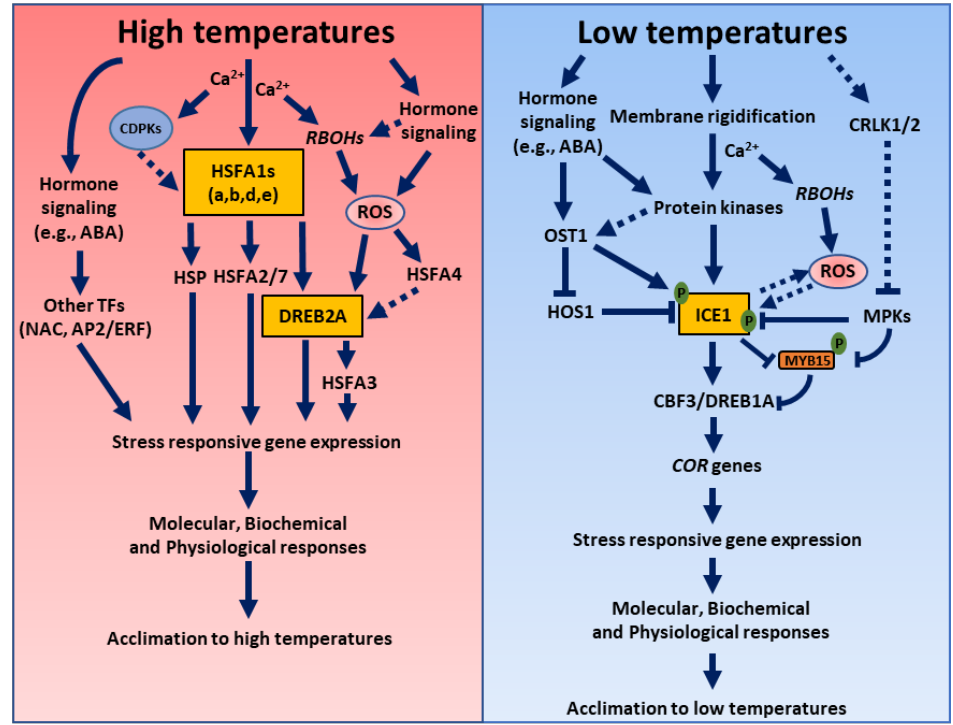
Figure 1. A schematic model showing coordination between various signaling components to induce acclimation responses to temperatures stress. The interplay between the ROS; hormones; and other signaling components such as Ca 2+ , CDPKs, MAPKs, and TFs determines the plant’s molecular, biochemical, metabolic and physiological responses to high or low temperatures. Left panel: Heat stress affects the membrane fluidity and simultaneously triggers hormone signaling pathways, resulting in increased cytosolic calcium, reactive oxygen species, and the activation of other cytoplasmic proteins. The intercellular calcium activates CDPKs or RBOHs, which result in ROS production. Hormones and ROS, along with other signaling components, interdependently activate multiple signaling pathways to alter the activity of the heat shock factors (e.g., HSFA1), which, in turn, activate other transcription factors like Dehydration-Responsive Element-Binding Protein2a ( DREB2A ), inducing the appropriate stress-responsive gene expression. Right panel: